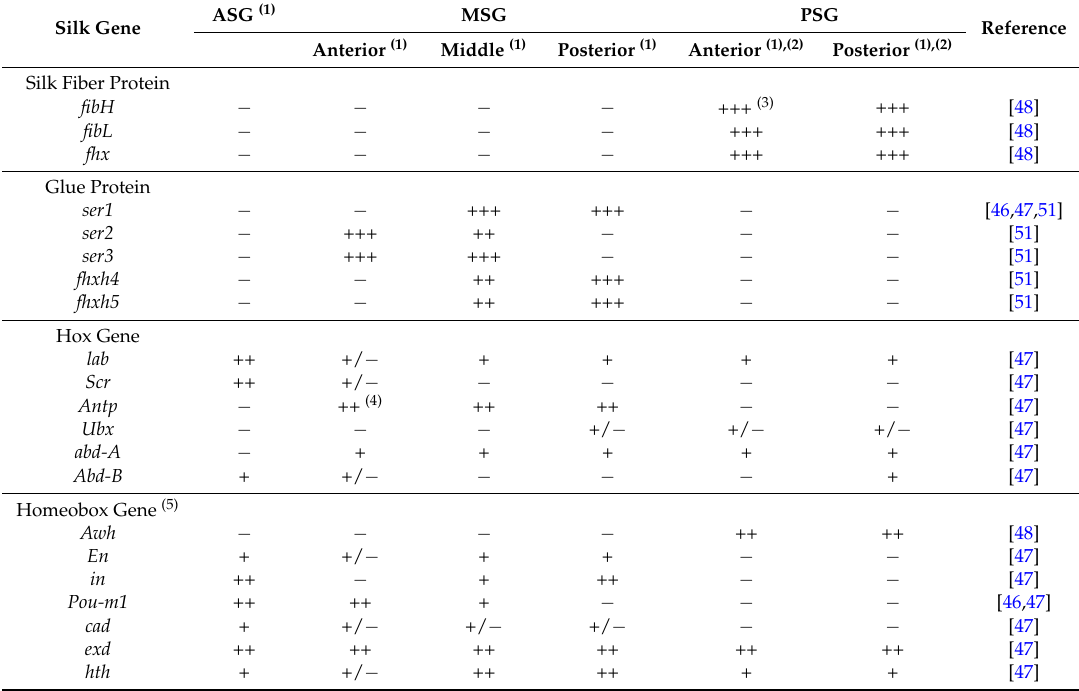
Region-specific expression of the genes for silk proteins, and Hox and some homeodomain-containing transcriptional factors in the silk